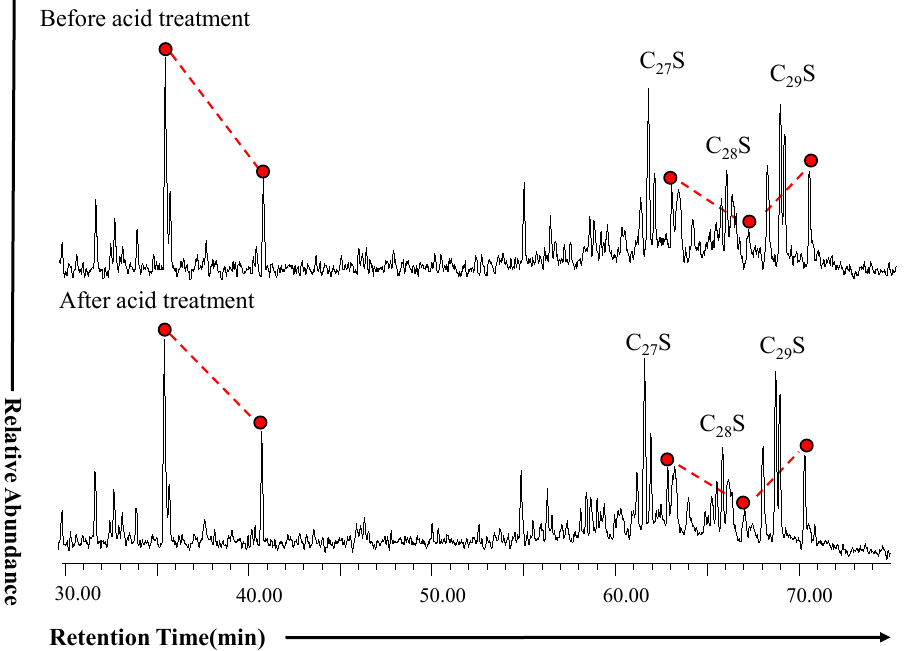
Figure 9. Saturated hydrocarbon fraction m / z 217 mass chromatogram of oil stains in the wellhead blockage before and after acidification of Well DH231.